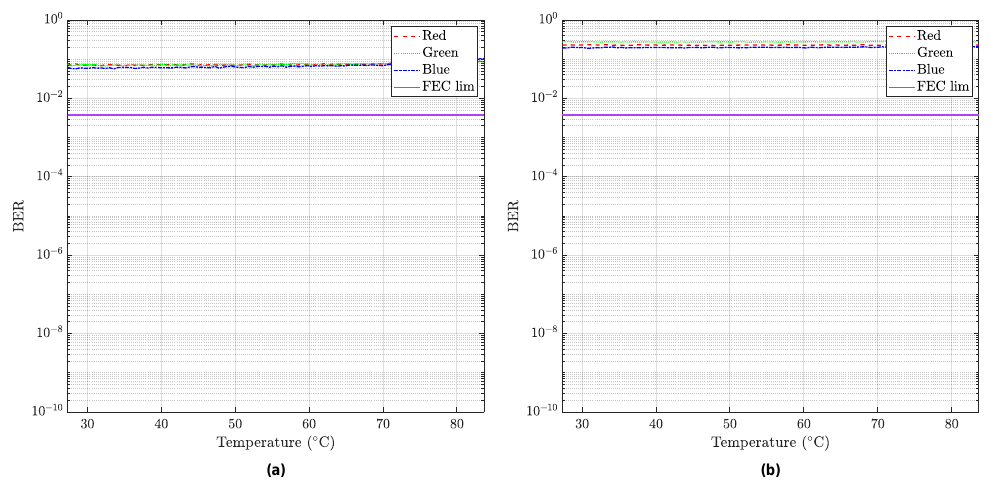
Figure 17. BER at different temperatures, compensating the channel using the CSI corresponding to 27°C and with a low SNR value (10 dB). ( a ) Sony IMX249 and ( b ) Foveon X3. Dashed line, dotted line, and dash-dot line correspond to red, green, and blue, respectively.